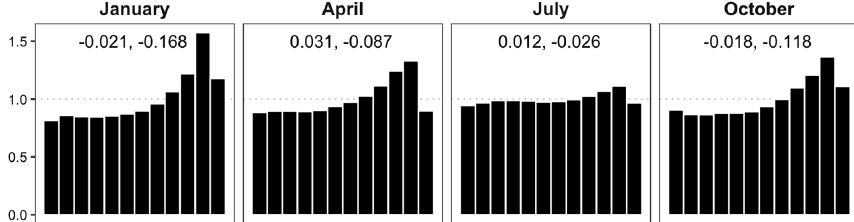
Figure 8. Verification rank histograms (density) for downscaled fields at representative months with cases of fully tied ranks removed. Estimated β -score (left) and β -bias (right) annotated.